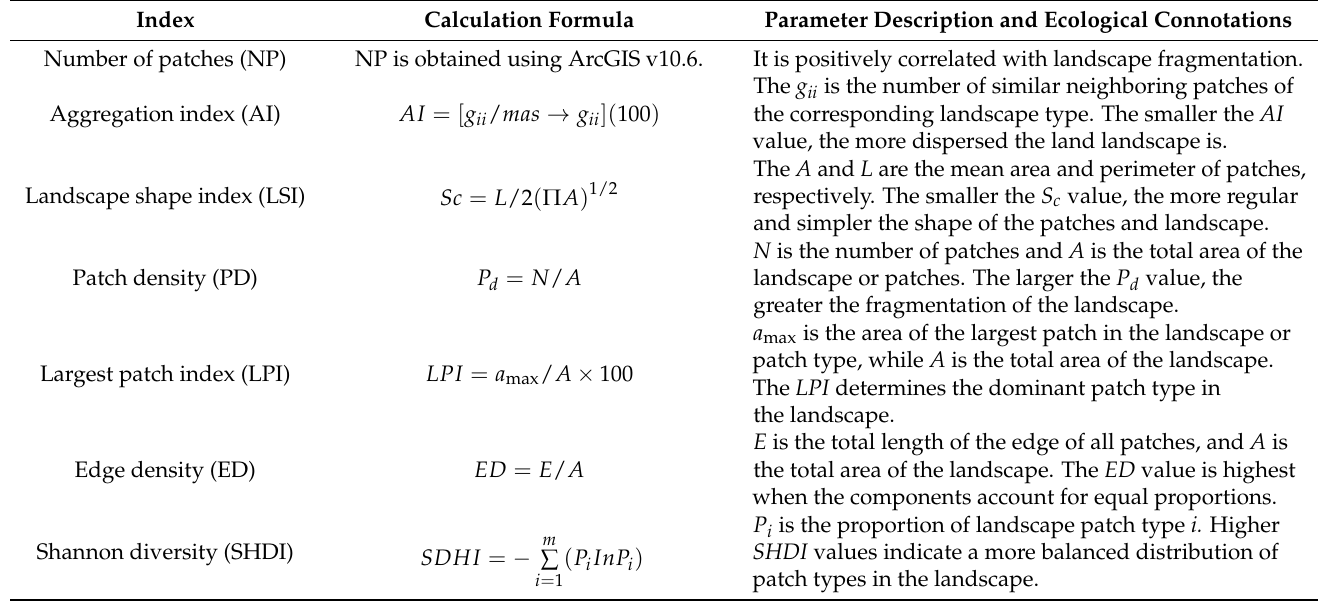
Table 2. Landscape pattern indices used in this study and their ecological connotations. Calculation Formula Parameter Description and Ecological Connotations Number of patches